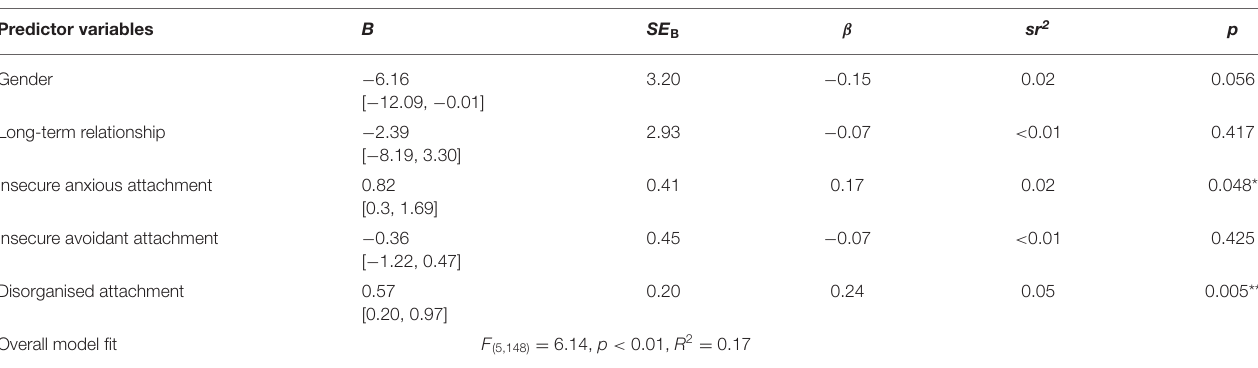
TABLE 3 | Summary of multiple regression analysis predicting punitive